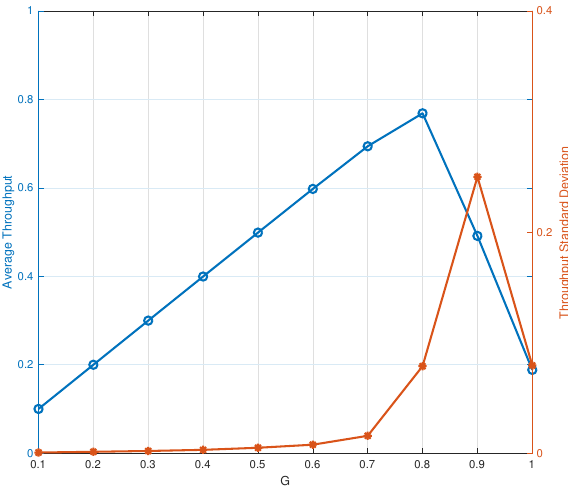
Figure 4. Average throughout and throughput standard deviation versus the instantaneous load G for IRSA with Λ ( x ) = 0.5 x 2 + 0.28 x 3 + 0.22 x 8